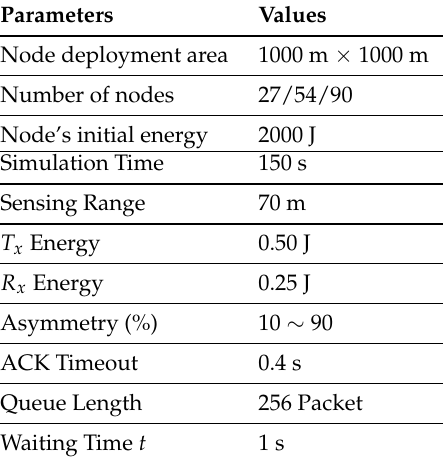
Table 4. Simulation parameters.